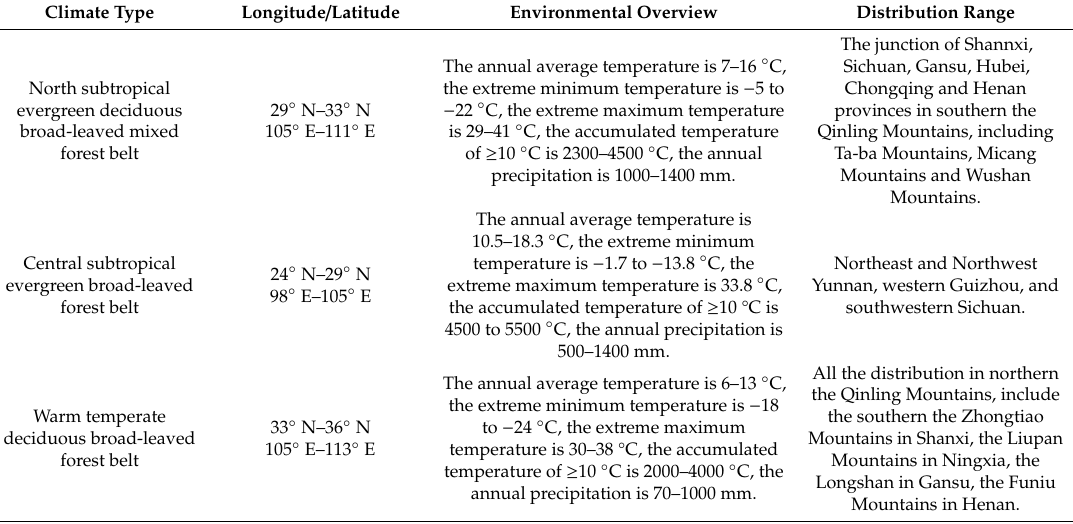
Figure 1. Present distribution of Pinus armandi Franch in China. The area where Dendroctonus armandi (Coleoptera: Curculionidae: Scolytidae) is located in the red box. Table 1. Profile of the natural distribution of Pinus armandi Franch .